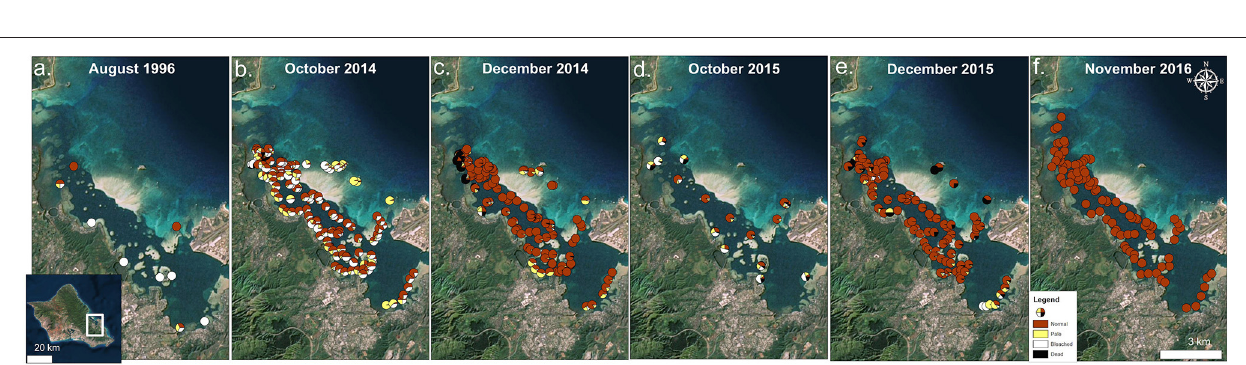
FIGURE 3 | Times series of bay-wide surveys on 31 August 1996 (a) , 14 October 2014 (b) , 1 December 2014 (c) , 16 October 2015 (d) , 8 December 2015 (e) , and 11 November 2016 (f) . Proportion of surveyed corals are shown as normal (red), pale (yellow), bleached (white), and dead (black). Survey data from 1996 (Jokiel and Brown, 2004 ) and 2014 (Bahr et al., 2015a) bleaching events are used with permission from authors. Photo credit: Quickbird Digital